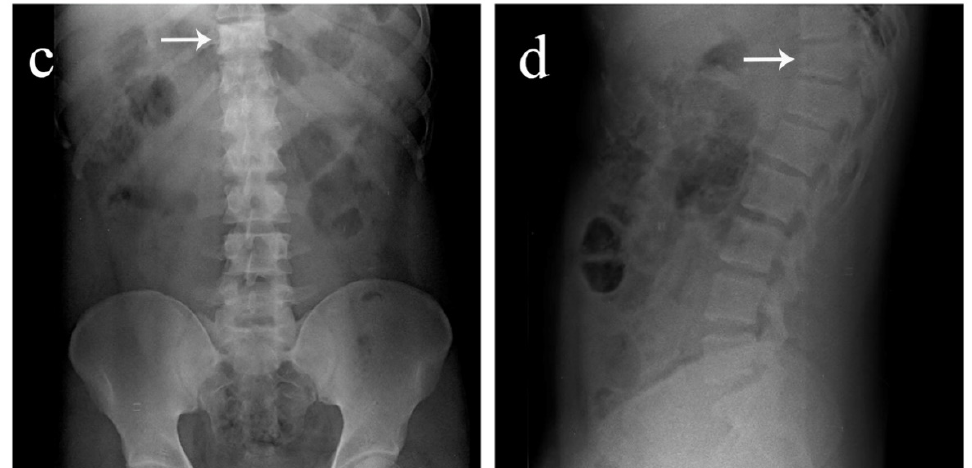
Figure 1. Antero-posterior and lateral view plain radiographs of a 35-year-old male who was brought to the emergency department with multiple abrasions over the trunk and pain in the upper back following a motor vehicle accident. He was conscious and well oriented with stable vitals. Upon examination, midline tenderness was elicited throughout his upper back. His motor power was 5/5 in all four limbs, and there was no sensory deficit. Plain radiographs revealed an obvious anterior wedge compression fracture of the T11 thoracic vertebra. However, since tenderness was elicited throughout the upper thoracic spine and not confined just to the T11 level, more fractures were suspected. On further examination of the anteroposterior view radiograph, it was noticed that the spinous process shadows of the upper thoracic vertebra were either absent or deviated. This brought suspicion of multiple spinous process fractures, which were later confirmed using a computed tomography (CT) scan. ( a ) Antero-posterior view of the thoracic spine showing absent or deviated spinous process shadows throughout the upper thoracic spine, raising suspicion of spinous process fractures. ( b ) Lateral view of the thoracic spine showing a compression fracture of T11 vertebrae (arrow). ( c ) Antero-posterior view of the lumbar spine where the T11 vertebra appears to be sclerotic (arrow). ( d ) Lateral view of the lumbar spine showing normal lordosis and the T11 compression fracture (arrow).